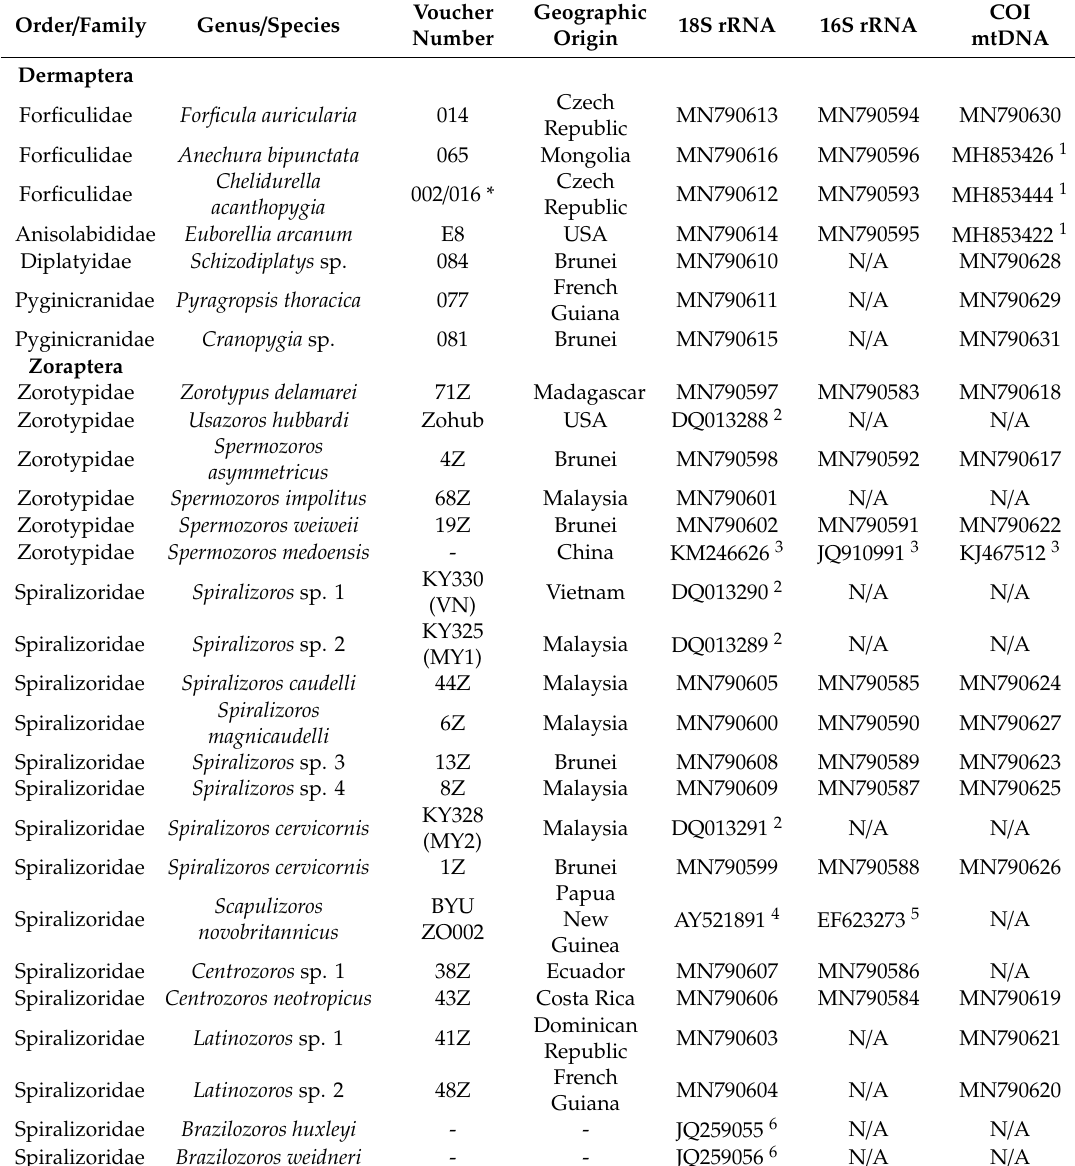
Table 1. List of taxa used for the phylogenetic reconstruction of Zoraptera, with voucher numbers, information on geographic origin, and GenBank accession